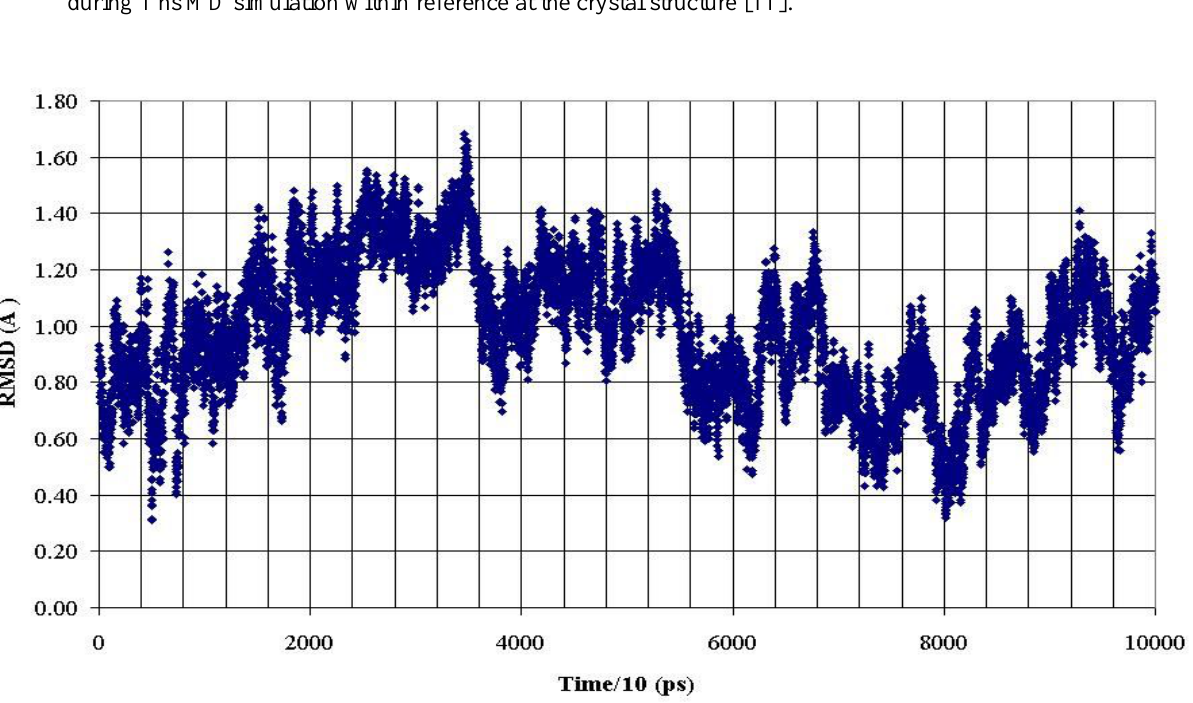
Figure 7. RMSD of backbone heavy atoms of the PDTRP fragment of the glycosylated peptide AHG21 (T5) during 1 ns MD simulation within reference at the crystal structure